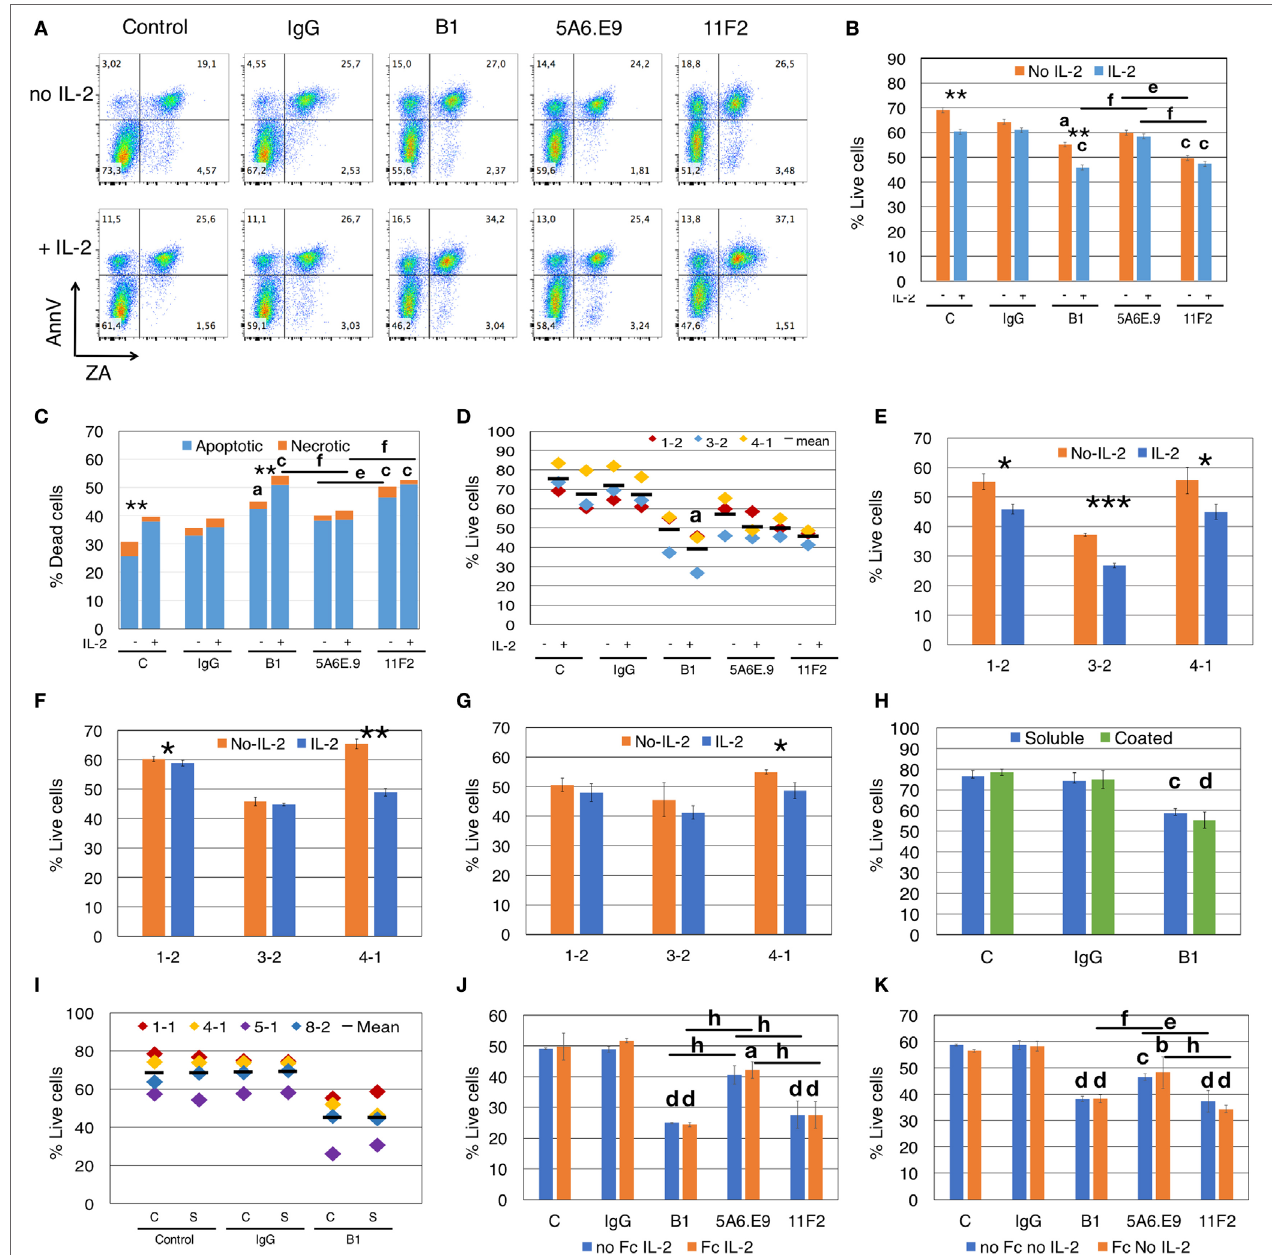
FigUre 2 | Anti- γδ TCR antibodies induce apoptosis, and effects are exacerbated by interleukin-2 (IL-2). (a) Addition of IL-2 to blocking assays increases apoptotic cell death of γδ T cells (Donor 1, culture 2 = 1-2). Apoptotic cells are annexinV (AnnV) positive; early apoptotic cells are in the top left quadrant. Positive staining for Zombie Aqua (ZA) indicates dead cells. (B) For the experiment shown in panel (a) , % live cells are plotted for γδ T cells treated with antibodies for 4.5 h in the presence or absence of IL-2. Error bars are SD for technical replicates. This experiment is representative of three biological replicates. (c) Most cell death induced by antibody treatment is apoptotic cell death (blue) and is enhanced in the presence of IL-2; orange indicates necrotic cell death. The graph depicts results from the experiment shown in panels (a,B) . (D) Compiled results of experiment shown in panel (B) from three different donor cultures (1-2, 3-2, and 4-1). (e) Individual experiments in which γδ Tc were incubated with B1, (F) 5A6.E9 or (g) 11F2. In panels (e–g) , Student’s t -tests reveal a significant difference in cell viability in the presence or absence of IL-2; * P < 0.05, ** P < 0.01, *** P < 0.001. (h) No differences in cell death were induced by soluble or immobilized (coated) B1 antibody treatment; however, significant cell death is observed comparing soluble B1- to IgG-treated cells. This is a representative example of three independent experiments; for this experiment, cells were from culture 1-1 on day 16. (i) Compiled results of experiment shown in panel (F) with four different donor cultures (1-1, 4-1, 5-1, and 8-2). (J) A representative example of two independent experiments in which γδ T cells were incubated with or without Fc blocking reagent for 10 min at room temperature prior to the addition of antibodies in the presence of IL-2. Shown here is the experiment with donor culture 8-2. (K) The experiment in panel (J) carried out in the absence of IL-2. Statistical analyses for all but panels (e–g) were as follows: two-way ANOVA followed by Bonferroni’s multiple comparisons tests were performed to identify significant differences between antibody-treated and IgG-treated cells ( a P < 0.05; b P < 0.01; c P < 0.001; d P < 0.0001) or among antibody treatments (line indicates groups compared; e P < 0.05; f P < 0.01; g P < 0.001; h P < 0.0001) as well as to determine significant viability differences in the presence or absence of IL-2 (* P < 0.05, *** P <